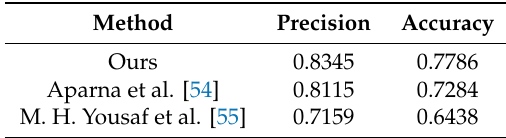
Table 8. The average of the classification accuracy and precision comparison results of the proposed method and the existing pothole detection method.